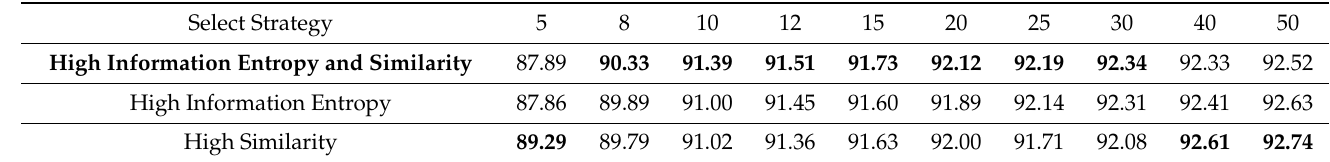
Table 3. OA of SVM classifier on Salinas dataset (%). Our method is highlighted in bold. Select Strategy